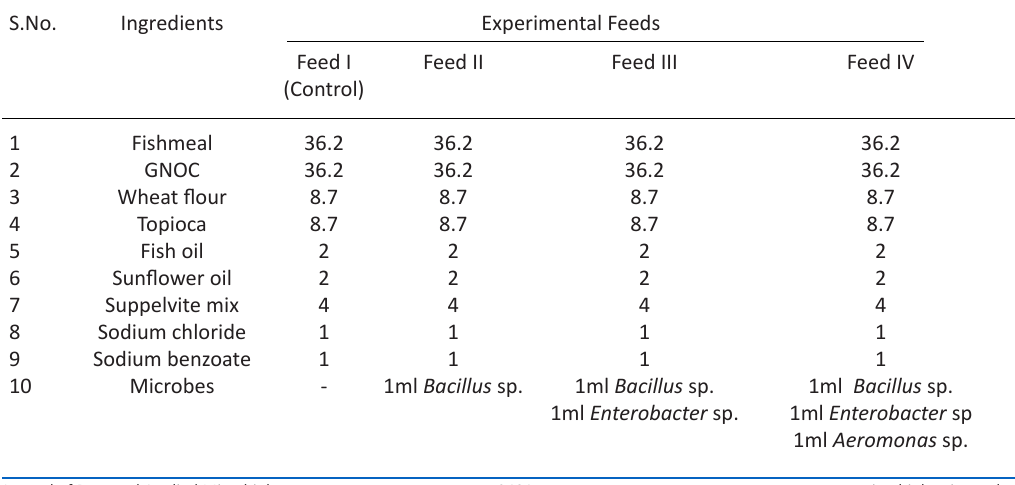
Table 2. Composition of different ingredients in Experimental feed (g/100gm) S.No.